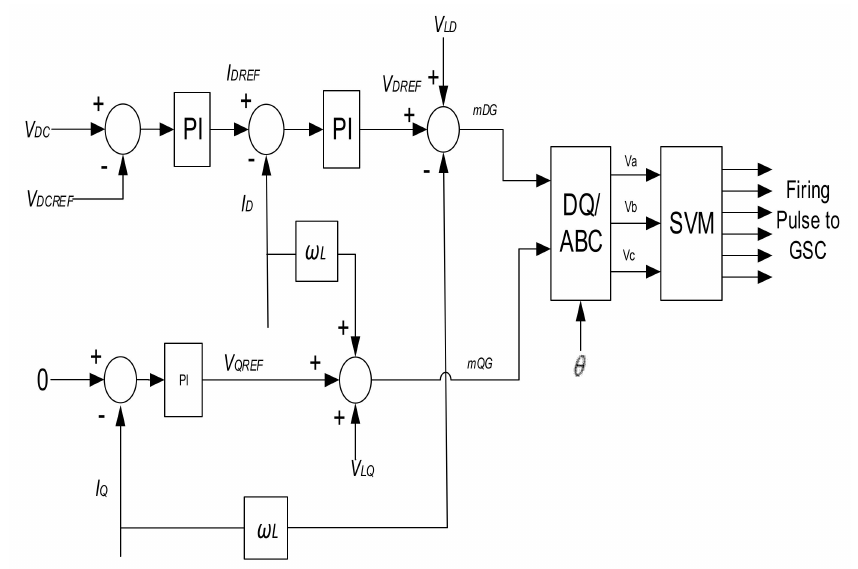
Figure 6. Grid side converter (GSC) decoupled controller.